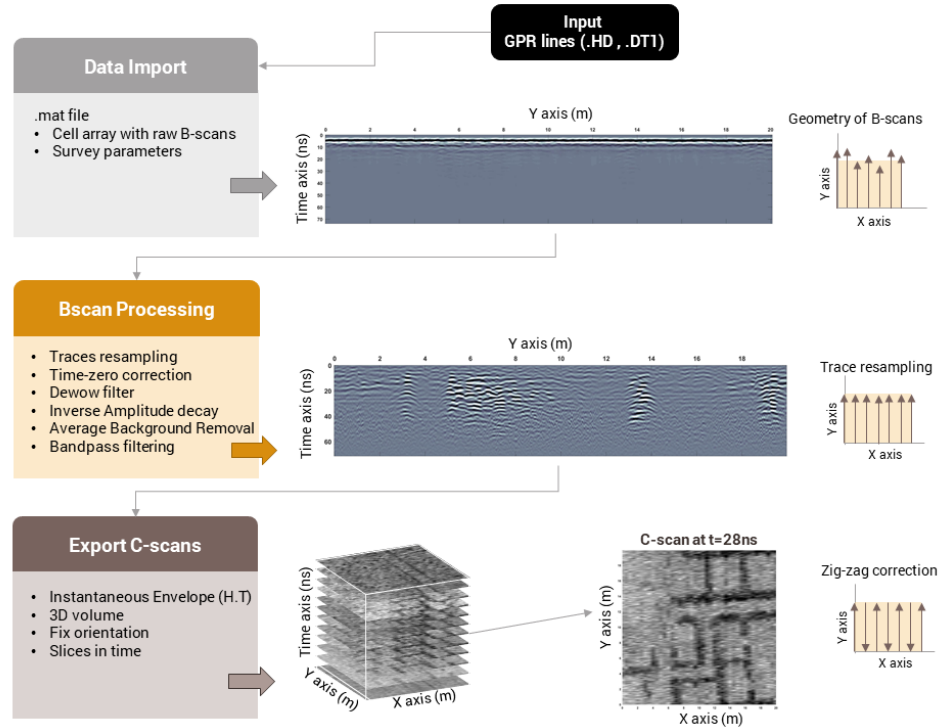
Figure 2. Data processing overview to produce C-scans used for CNN training data. The presented examples were collected from Demetria’s archaeological site in Magnesia, Greece. Trace reposition and zig-zag correction were applied only for survey grids that required it. The B-scans show the effect of the applied workflow before (top) and after (middle).